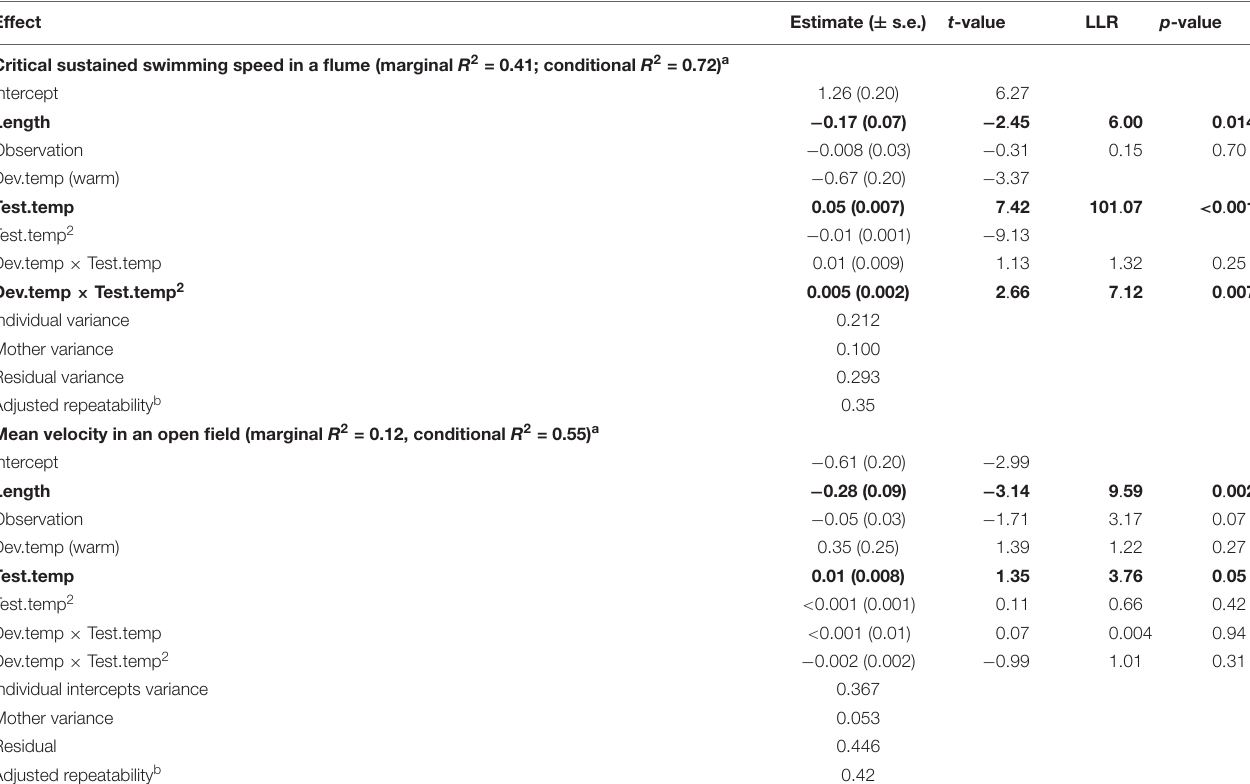
TABLE 1 | Linear mixed effect model predicting mean velocity and critical sustained swimming speed ( U crit ) in the Atlantic mollies . Effect Estimate ( ± s.e.) t -value LLR p